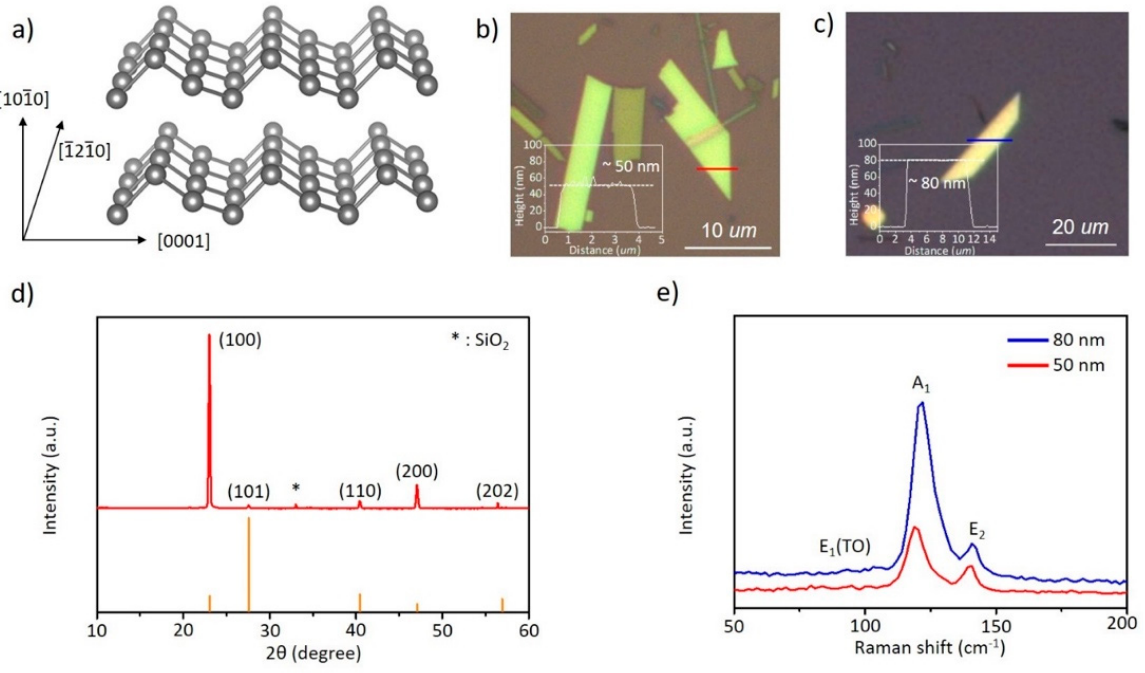
Figure 1. 2D Tellurium by hydrothermal method. ( a ) Crystal structure of 2D Tellurium; ( b , c ) Optical images and AFM results of 2D Tellurium with 50-nm and 80-nm thickness, respectively; ( d ) X-ray diffraction with simulation; ( e ) Raman scattering according to ( b , c ).